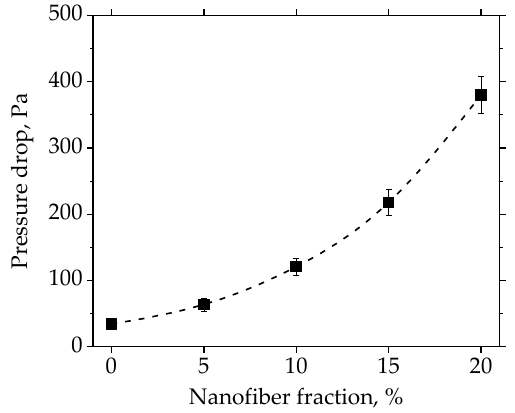
Figure 6. Pressure drop of filter paper with different fractions of nanofibers.